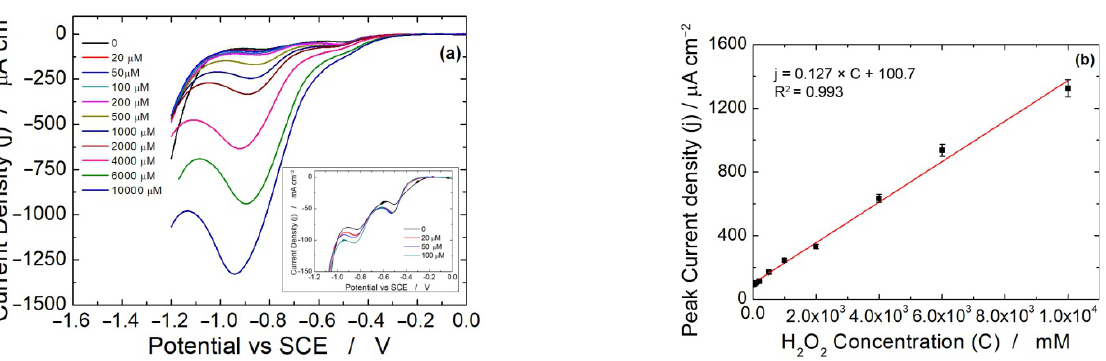
Figure 5. ( a ) LSV experiments at increasing H 2 O 2 concentration and ( b ) corresponding calibration line. The tests were performed in pure MEM and at 37 °C (N = 3).